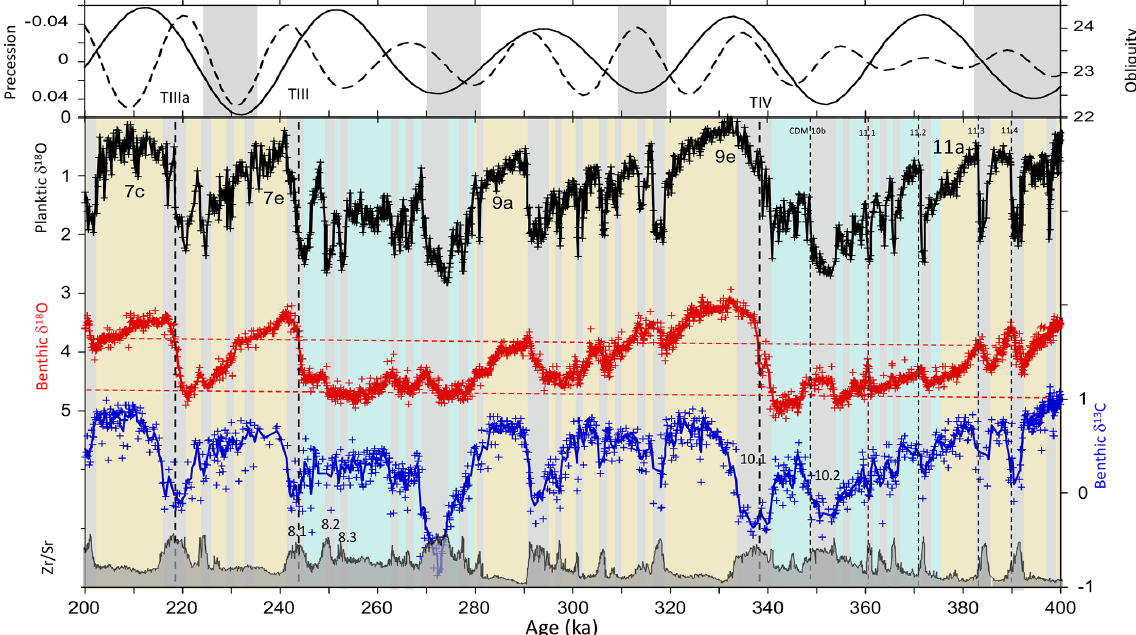
Figure 7. Same as Fig. 6 but for 200–400ka. Heinrich stadial 8.1, 8.2, 8.3, 10.1, and 10.2 are labelled after Channell et al. (2012). Note strong MCV on MIS 11 to 10 transition culminating in HS 10.2.